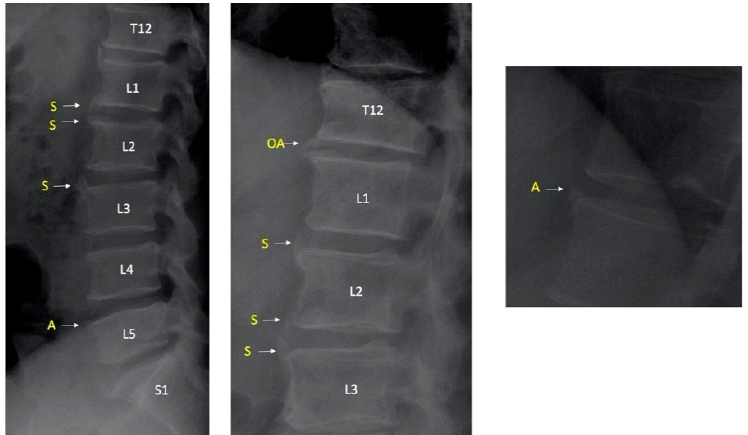
Figure 1. Examples of syndesmophytes and ambiguous lesions. S indicates syndesmophytes and A indicates ambiguous lesions; OA indicates osteophyte. T12 indicates 12th thoracic vertebra and L1/L2/L3/L4/L5 indicate 1st, 2nd, 3rd, 4th, 5th lumbar vertebrae respectively and S1 indicates 1st sacral vertebra.